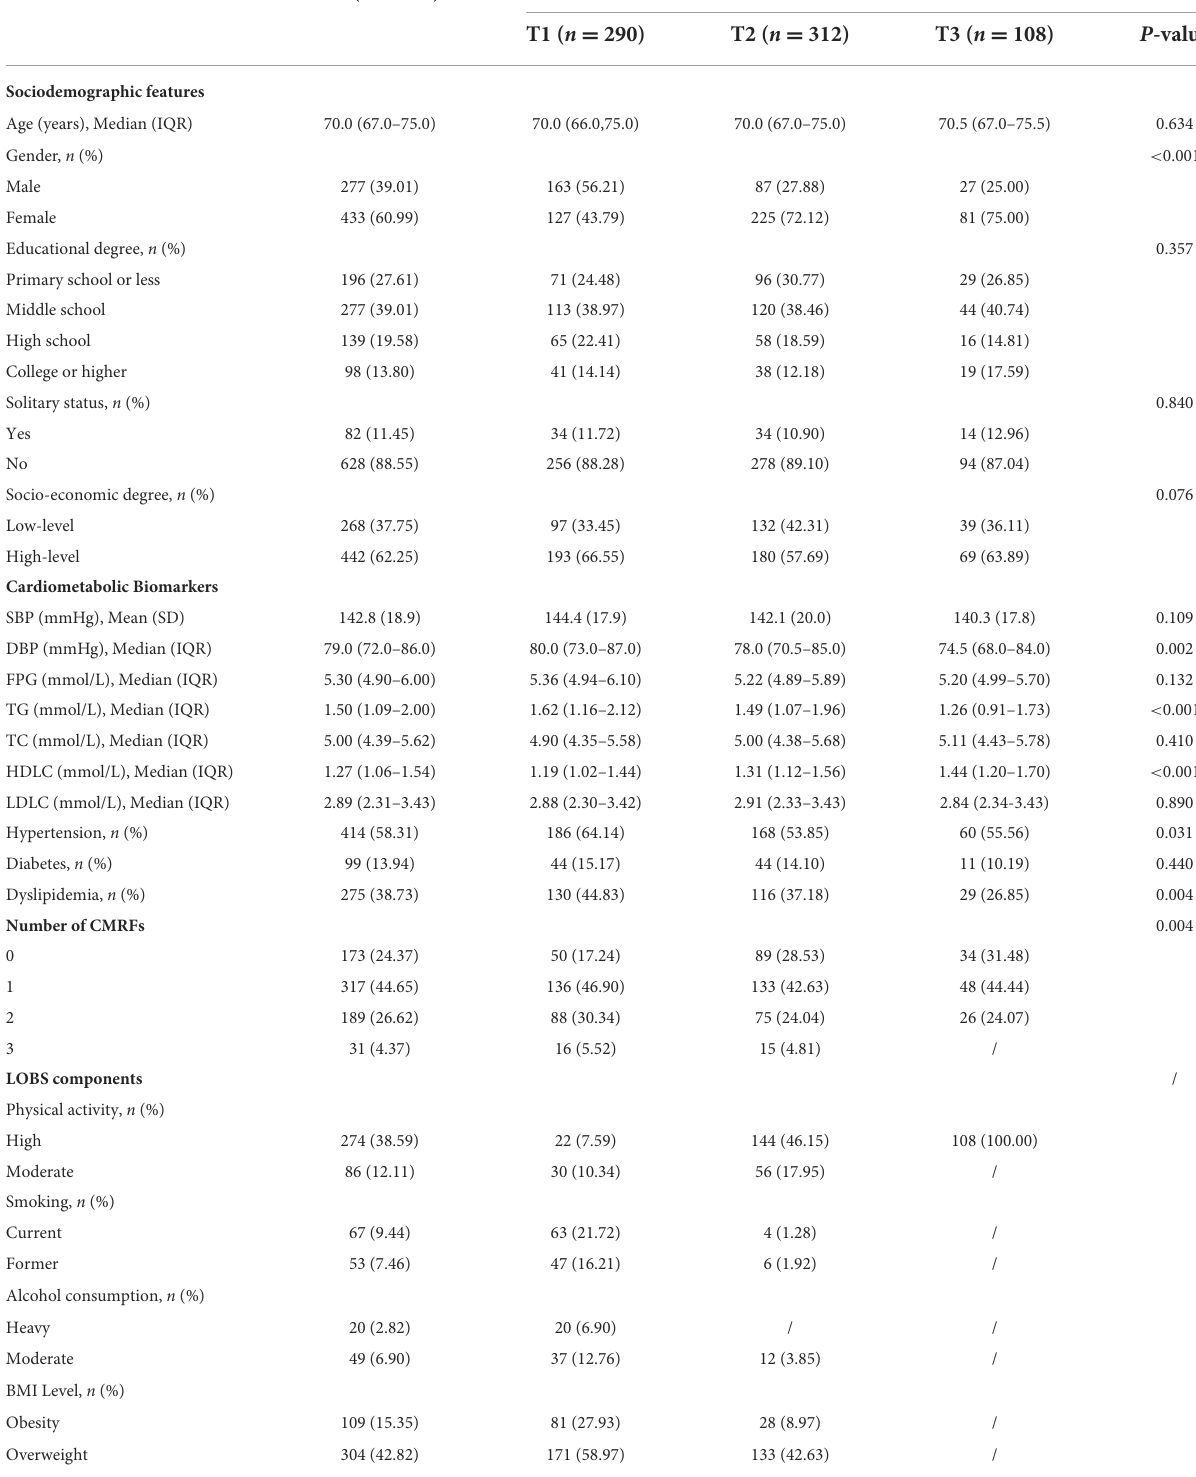
TABLE 2 The characteristics of selected participants according to lifestyle-based oxidative balance scores